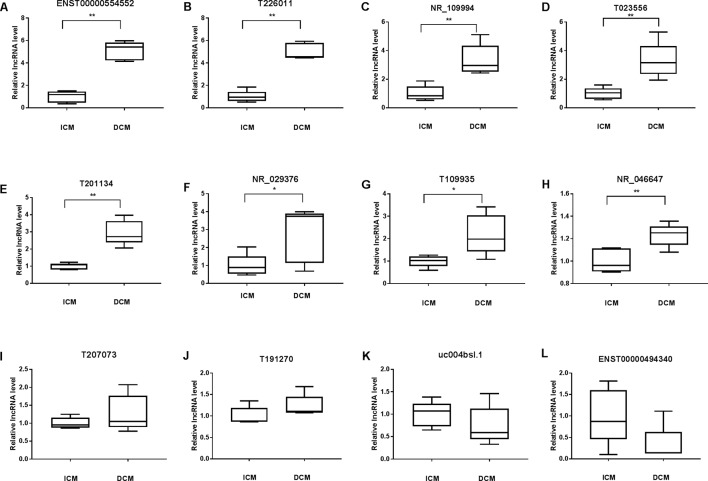
Validation of the differential expression of long noncoding RNAs (lncRNAs) by quantitative real-time PCR (qRT-PCR) (A–L). Levels of the lncRNA (T226011, ENST00000554552, T201134, T023556, T109935, NR_109994, NR_046647, NR_029376, ENST00000494340, T191270, T207073, uc004bsl.1) in plasma of patients with dilated cardiomyopathy (DCM) or ischemic cardiomyopathy (ICM). DCM group, n = 11; ICM group, n = 9. *p 0.05 versus control, **p 0.01 versus control.